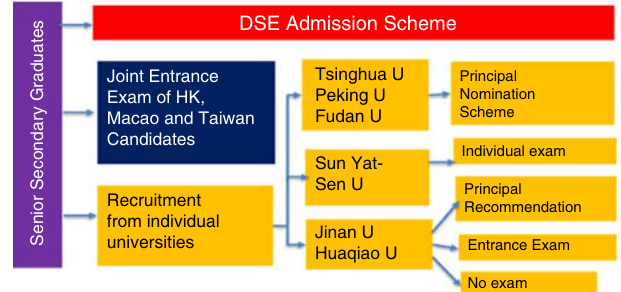
Figure 2. Admission